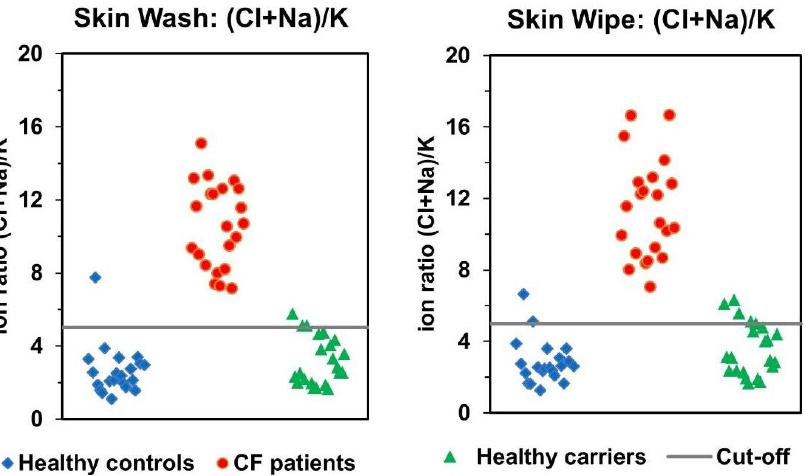
Figure 5. Comparison of (Cl − + Na + )/K + ion ratio from skin-wash and skin-wipe samples. Both datasets were obtained from the same persons, sampling was performed at the same time using both forearms. Each data point is an average of two samples taken from right and left forearm.